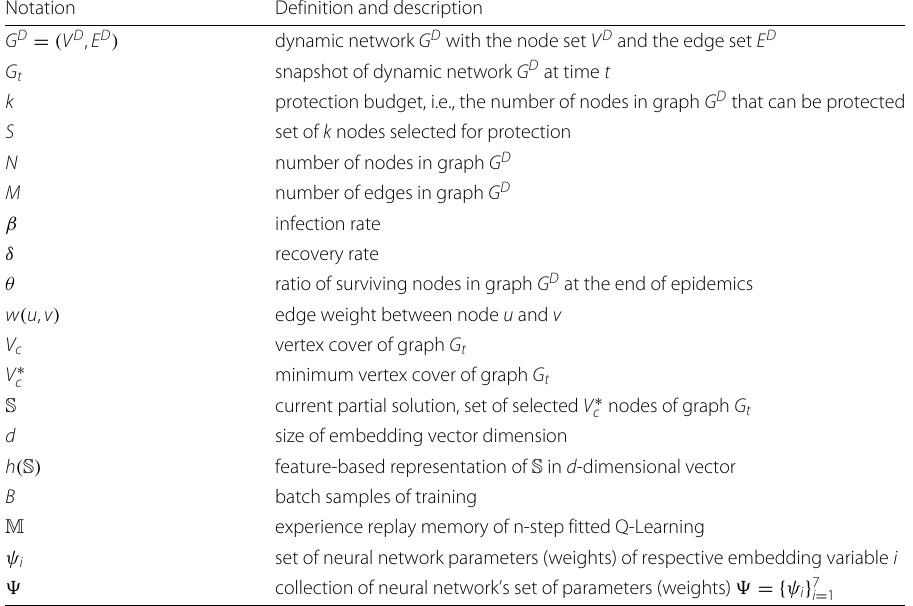
Table 1 Summary of Symbols and Notations